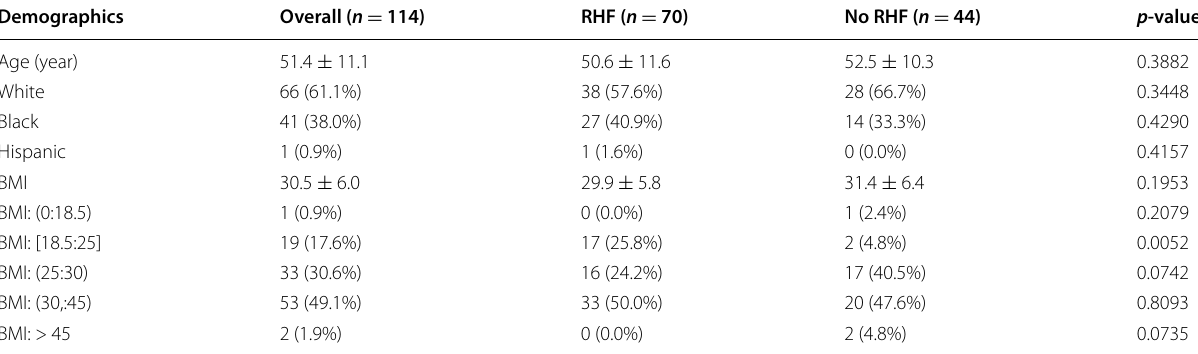
* p ‑values comparing patients with RHF vs. no RHF. **For continuous variables mean